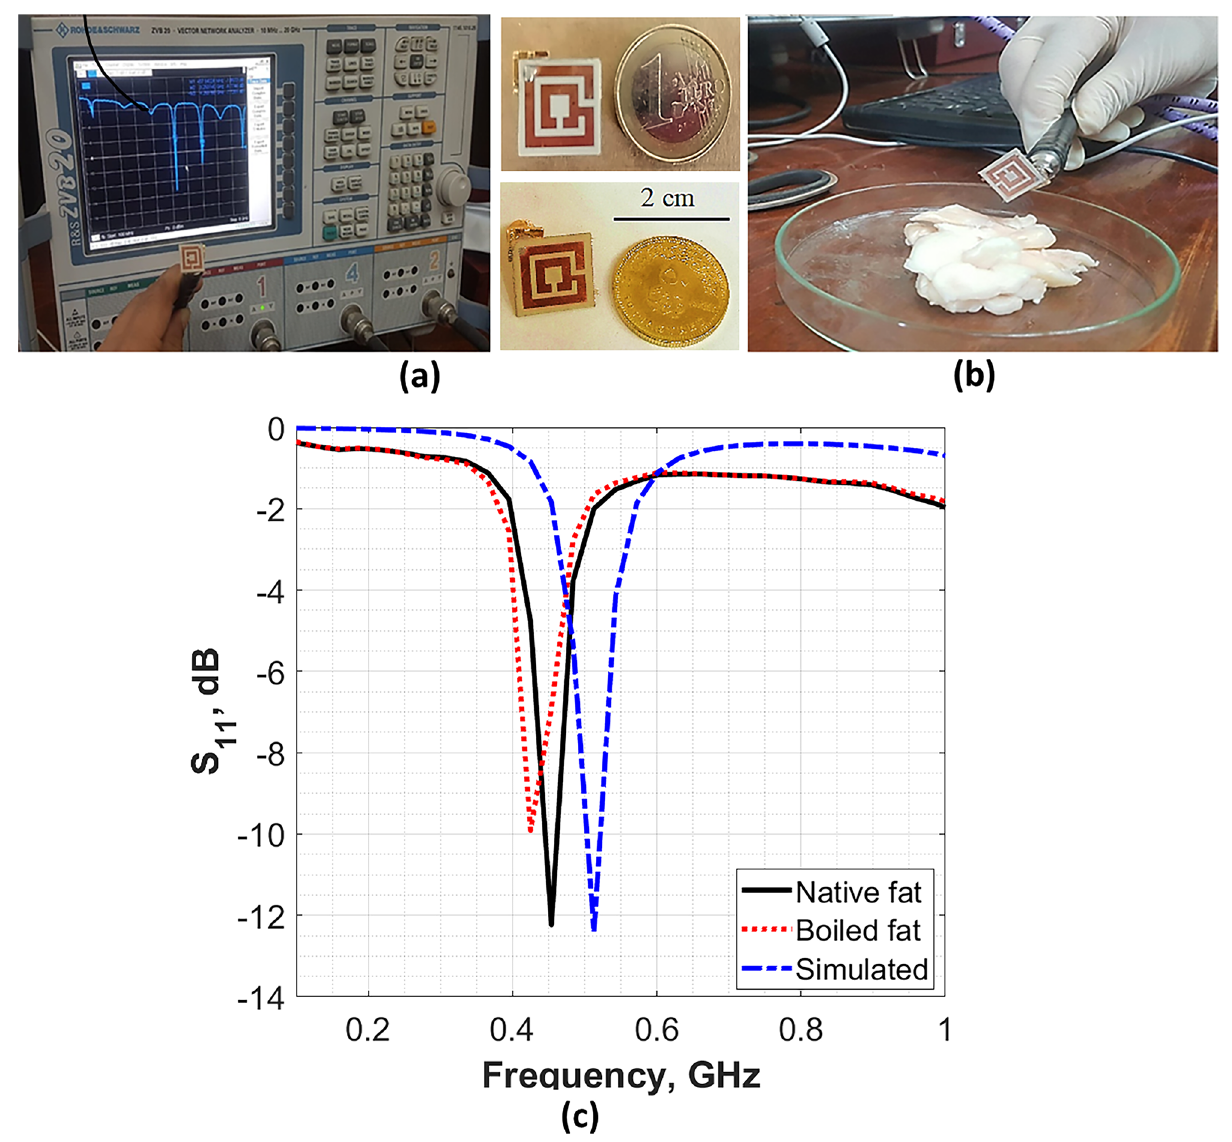
Figure 7. ( a ) A photograph of the fabricated antennas, ( b ) a photograph of the antenna with studied fat sample, ( c ) the S 11 parameters for simulation, normal and boiled fat.